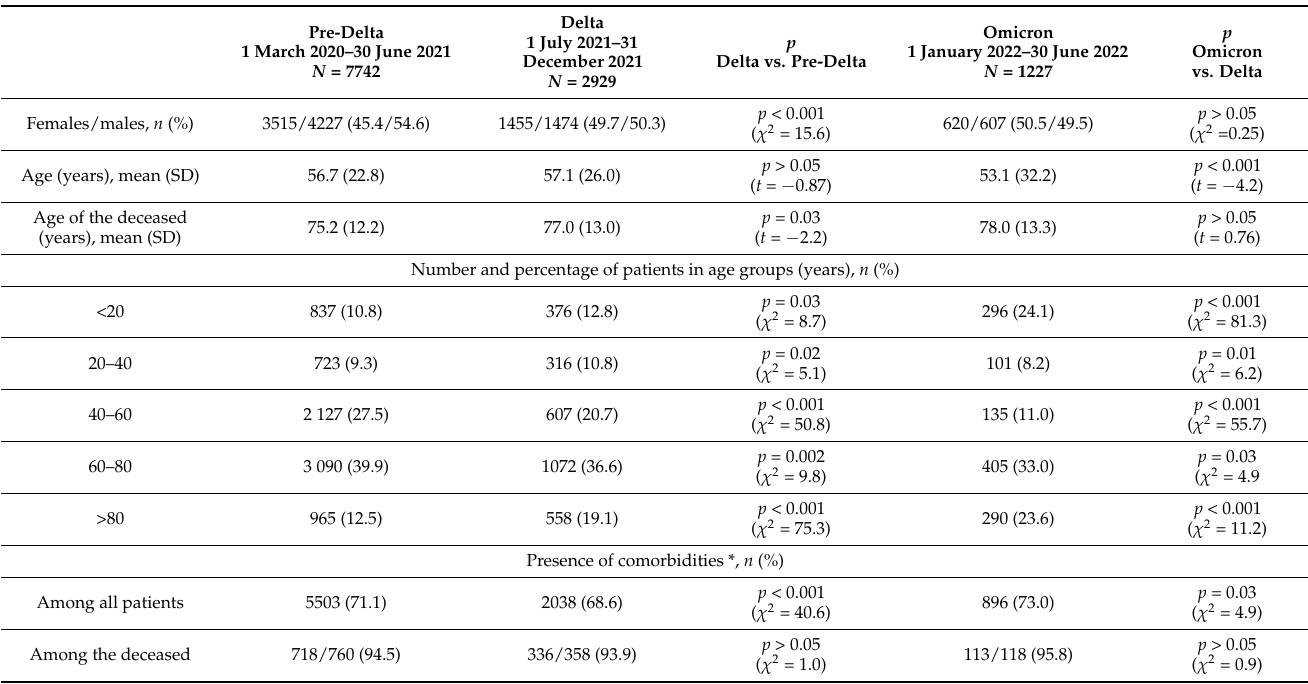
Table 1. Characteristics of patients hospitalized during periods with the dominance of particular SARS-CoV-2